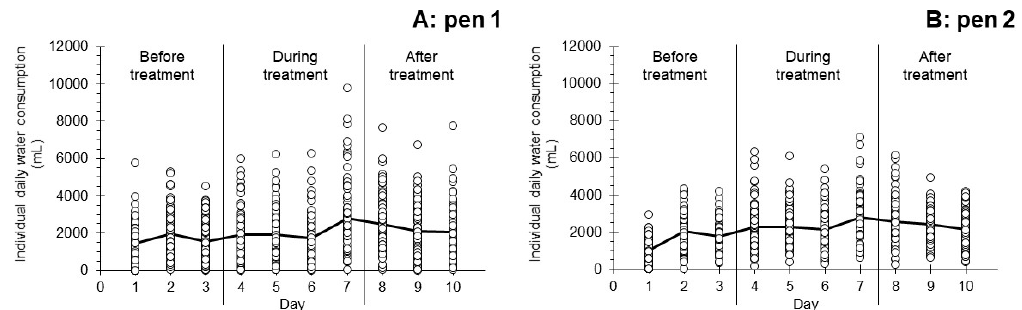
Figure 3. Individual daily water consumption of 96 lambs in pen 1 (4 lambs were not detected at the drinking troughs) and 98 lambs in pen 2 (1 lamb was not detected and 1 lamb died during the experiment), 3 days before, 4 days during and 3 days after the administration of a SDM-TMP combination (Trisulmix ® Liquid, 37.4 mg/kg/24 h SDM + 8.0 mg/kg/24 h TMP) in the drinking water. Each circle corresponds to the daily water consumption of one lamb. The solid line links the average daily water consumption. Antibiotics 2020 , 9 , x FOR PEER REVIEW